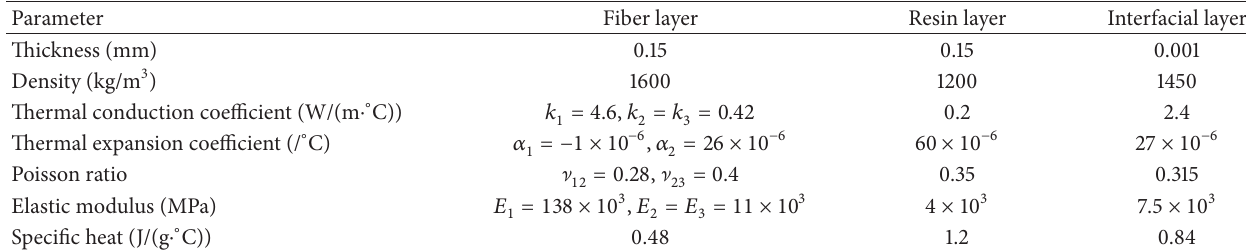
Figure 2: (a) Steady-state conduction of a lamina; (b) steady-state conduction of laminates. Table 1: The property of CF/EP laminates at room